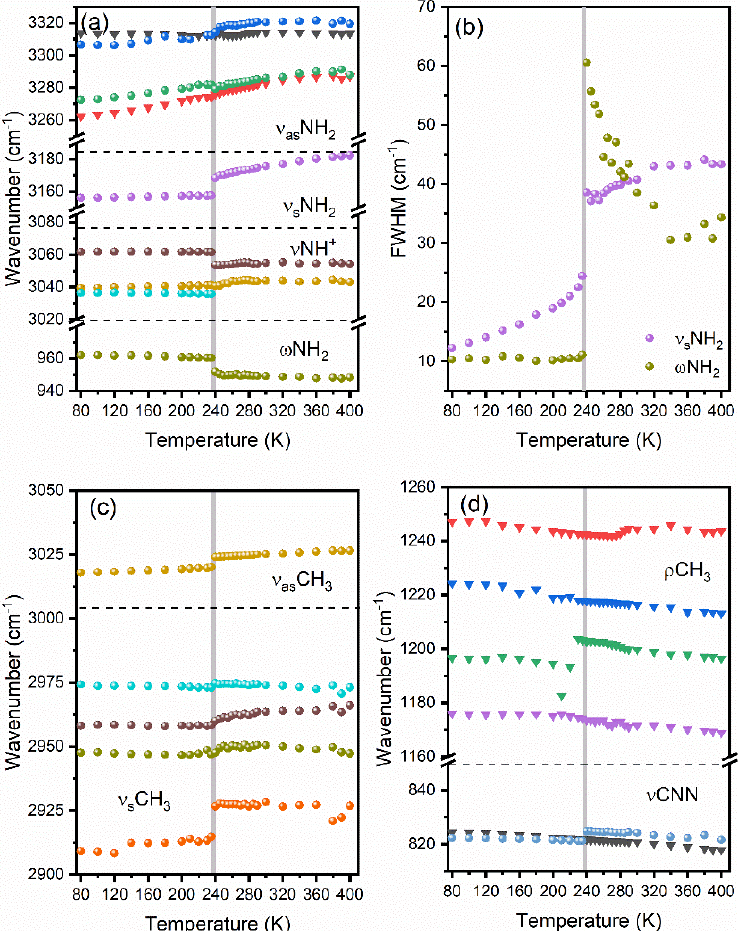
Figure 5. The thermal evolution of positions ( a , c , d ) and widths ( b ) of selected Raman (circles) and IR (triangles) bands corresponding to stretching and wagging vibrations of NH 2 and NH + groups ( a , b ), stretching vibrations of CH 3 ( c ) and stretching vibrations of CNN skeleton and rocking vibration of CH 3 group ( d ). Horizontal dashed lines separate ranges of different modes, and vertical grey lines correspond to the temperature of PT.